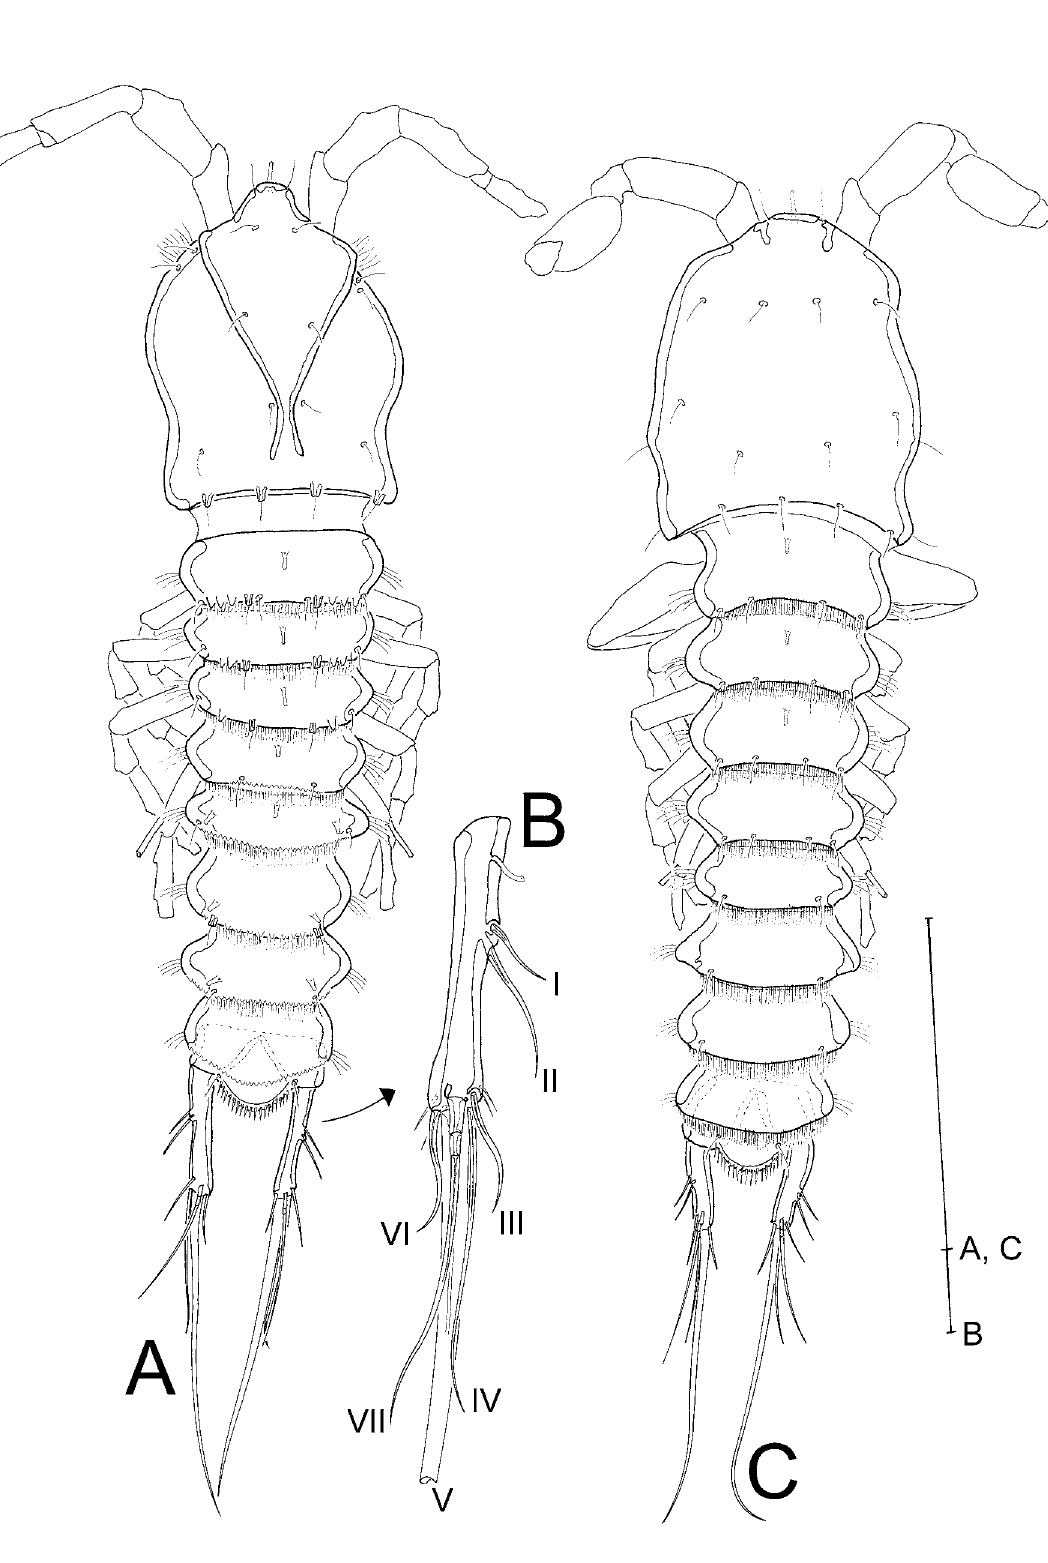
Fig. 16. Laophontodes monsmaris sp. nov. A–B . Allotype, ♀ (SMF 37121/1). A . Habitus, dorsal view. B . right furcal ramus, dorsal view. C . Holotype, ♂ (SMF 37120/1-2), habitus. Scales: A, C = 100 µm, B = 50